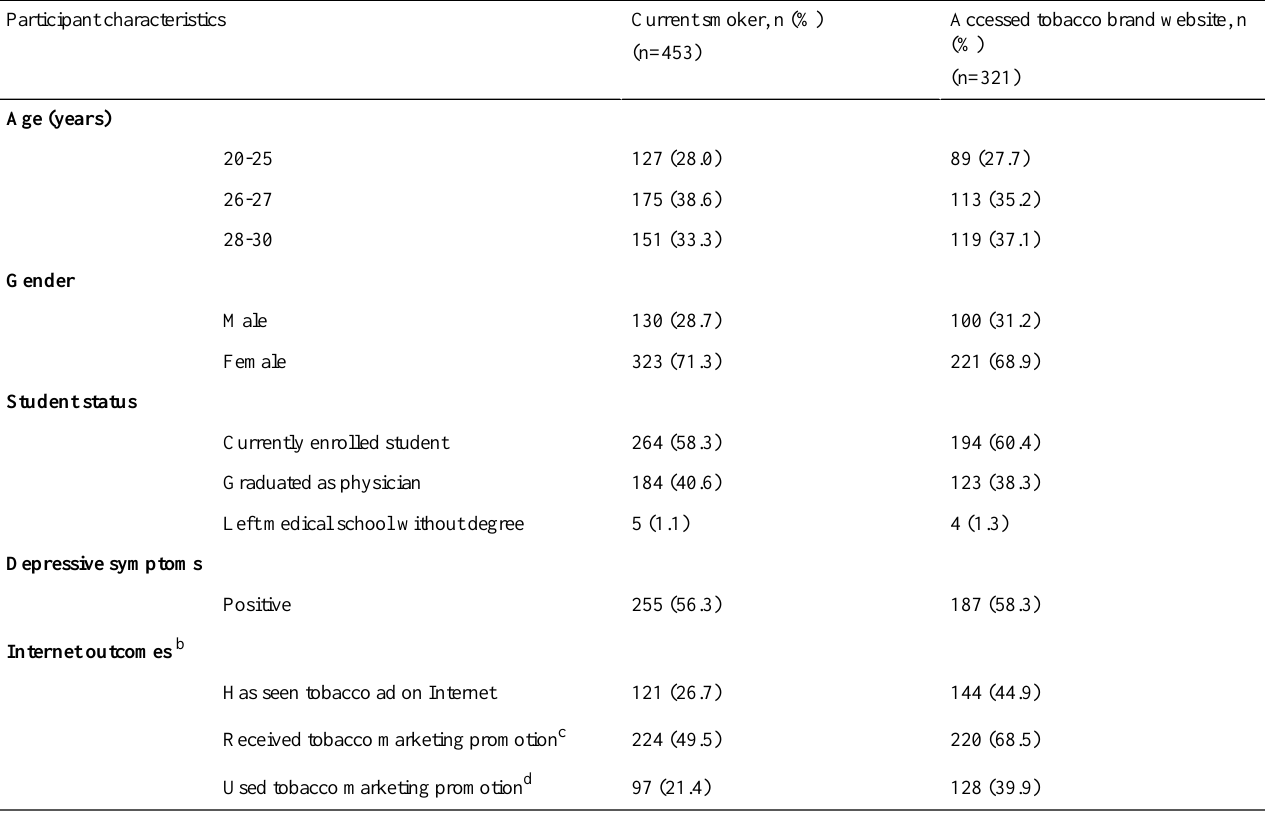
Table 2. Smoking behavior and use of tobacco brand websites among medical students and physicians (n=1659), Buenos Aires, Argentina, 2011. a